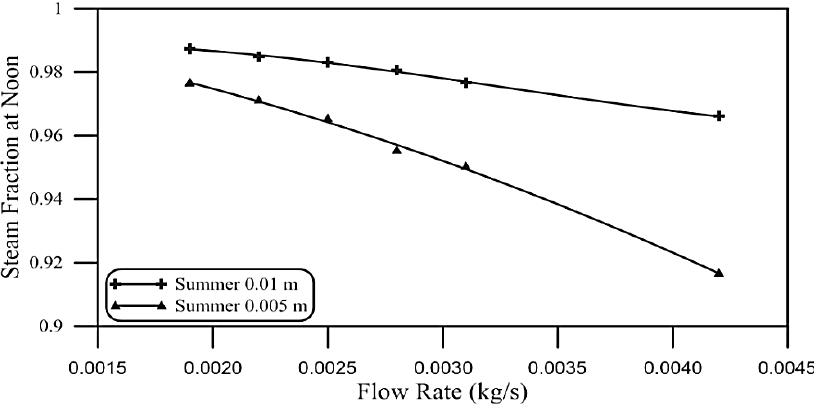
Figure 13. Steam fraction at noon for the 0.005 m and 0.01 m tubes on a summer day.